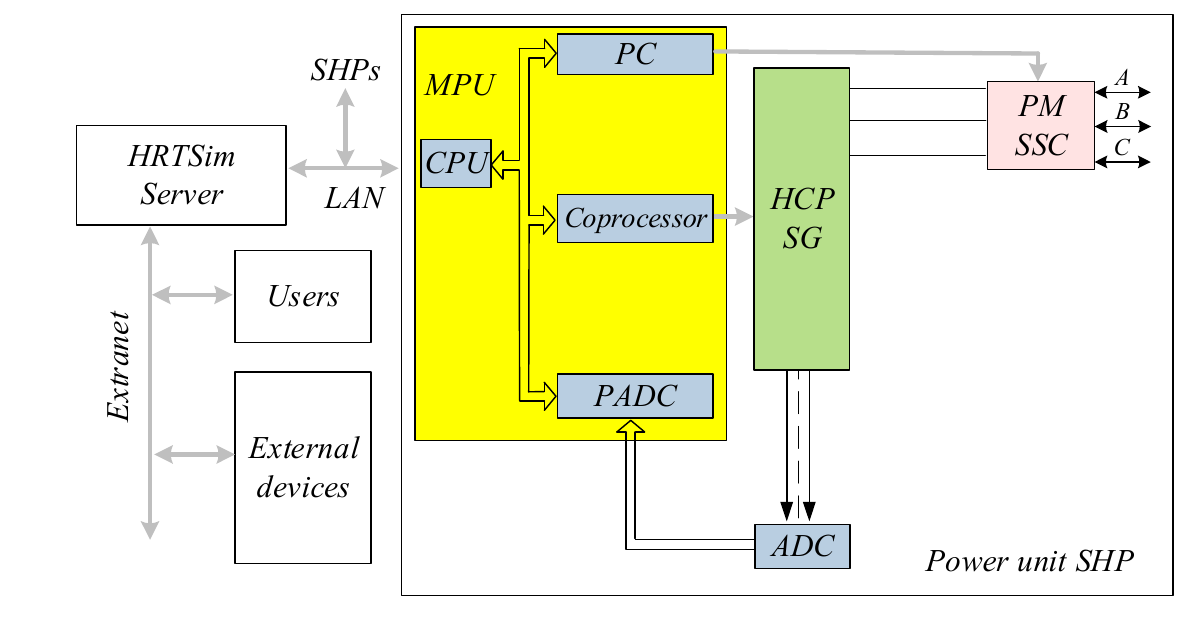
Figure 3. The block diagram of the power unit SHP.